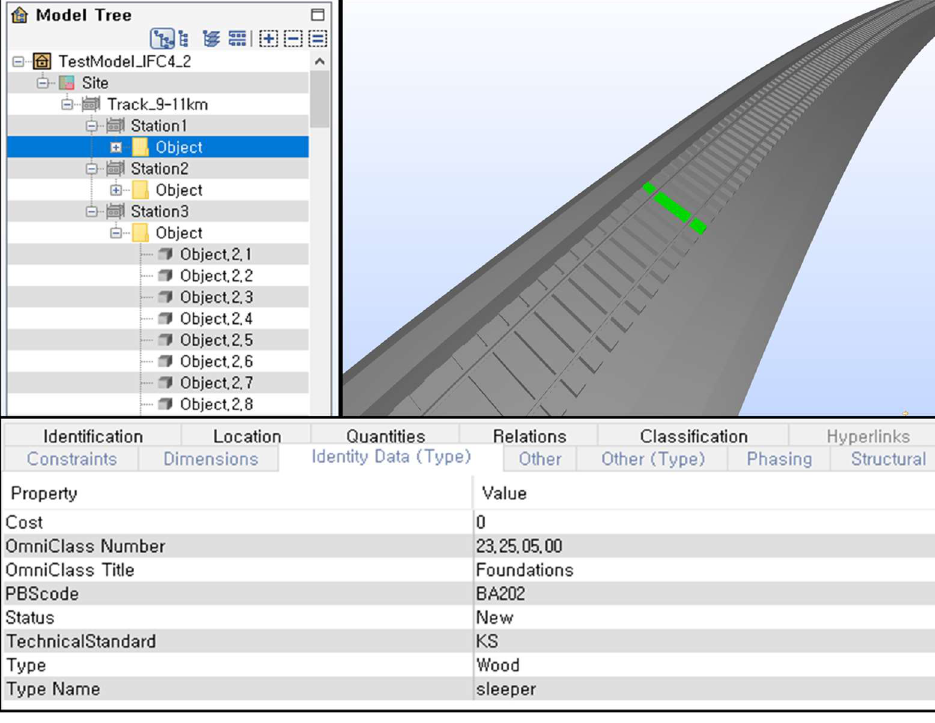
Figure 13. IFC4-based model in Solibri Model Checker.